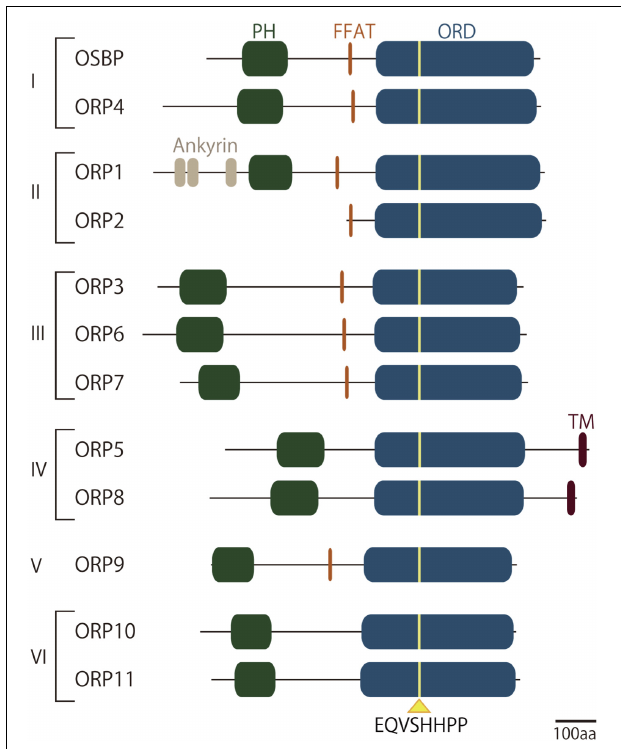
FIGURE 2 | Domain structures of oxysterol-binding protein-related protein (ORP) family proteins. Schematic cartoon representing the domain structures of ORP family proteins in mammals. ORPs in mammals are subdivided into six groups according to their sequence homology and domain organization. They have a well-conserved lipid-binding domain called oxysterol-binding protein-related domain (ORD), in which a consensus lipid-binding motif EQVSHHPP is located. Most but not all of ORPs possess a PH domain that binds phosphoinositides such as PI4P and/or PI(4,5)P 2 in the target membranes. Endoplasmic reticulum (ER) targeting determinants such as the FFAT (two phenylalanines in acidic tract)-motif, which is recognized by ER-resident membrane protein VAPA or VAPB, or membrane anchoring domain facilitates the localization of ORPs at membrane contact sites (MCSs) between the ER and other membranes. ORD, oxysterol-binding protein-related domain; FFAT, two phenylalanines in acidic